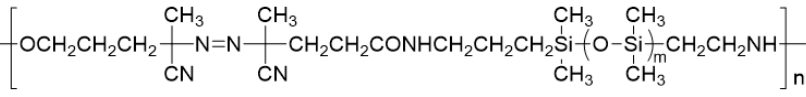
Figure 1. Chemical structure of macro-azo-initiator (MAI) (VPS-1001).